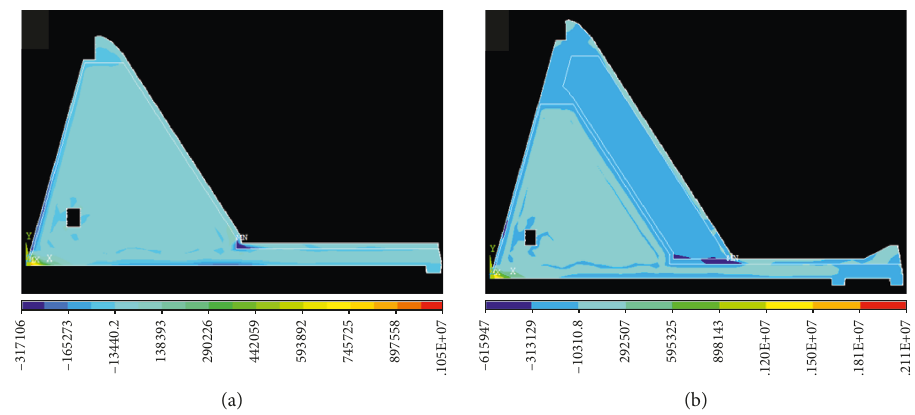
Figure 10: Contour of the maximum stresses of the dam body: (a) initial section and (b) final section.